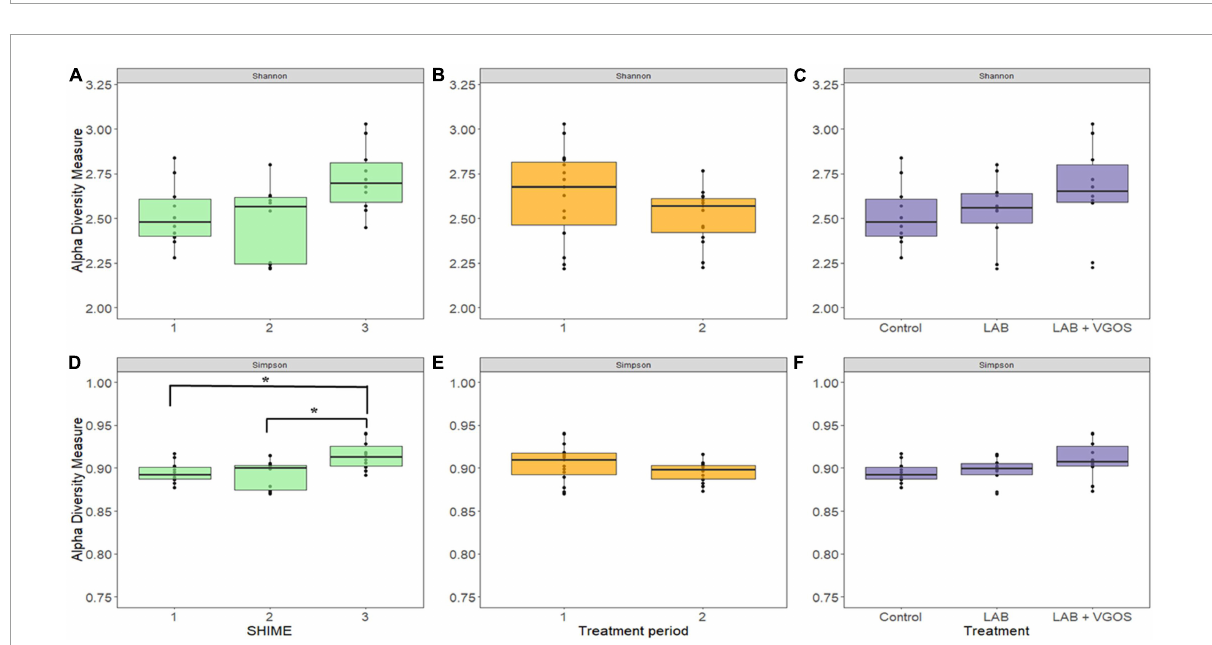
FIGURE7 Shannon (top) and Gini-Simpson (bottom) indices for measurement of alpha diversity between SHIMEs (A,D) , treatment periods (B,E) , and treatments (C,F) . Significant differences in alpha diversity, as denoted by the asterisks in (D) , were calculated based on the Wilcoxon Rank Sum test and adjusted using the Benjamini-Hochberg false discovery rate (p <